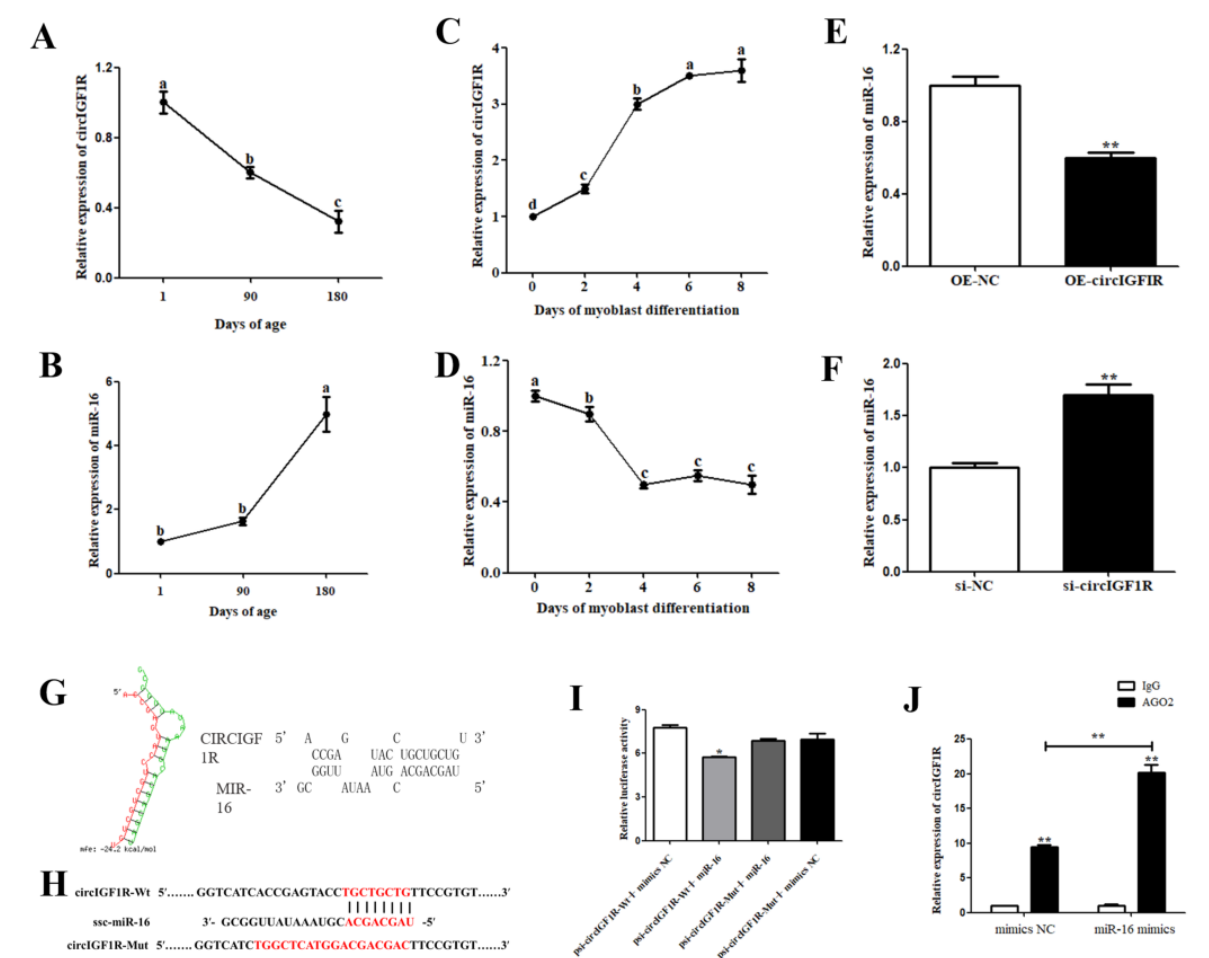
Figure 6. CircIGF1R serves as a miR-16 sponge. ( A , B ): circIGF1R and miR-16 expression in muscle tissue at different stages. ( C , D ): circIGF1R and miR-16 expression during the myoblast differentia- tion of pig satellite cells. ( E , F ): miR-16 expression after overexpression/interference of circIGF1R. ( G ): RNhybrid was used to predict binding sites of circIGF1R and miR-16. ( H ): The sequence of wild and mutant type vectors. ( I ): Dual-luciferase reporter assay. ( J ): AGO2-RIP assay. Different lower case letters indicate p < 0.05. ** p < 0.01, * p < 0.05. RNhybrid online software predicted that miR-16 forms a secondary structure with circIGF1R through base complementary pairing with a minimum binding free energy of − 24.2 kcal/mol, which is evidence of a strong binding ability (Figure 6G). The psiCHECK2- circIGF1R-Wt and psiCHECK2-circIGF1R-Mut vectors are shown in Figure 6H. The dual- luciferase reporter demonstrated that luciferase activity was reduced when co-transfected with psiCHECK2-circIGF1R-Wt+miR-16 mimics compared with that after transfection with psiCHECK2-circIGF1R-Mut+miR-16 mimics. Compared with the co-transfection